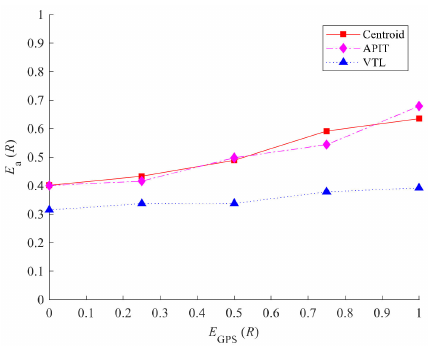
Figure 13. e GPS versus average estimation error E a (S = 200 × 200 m 2 , N t = 200, r a = 40%, R a = R = 20 m, K = 6).